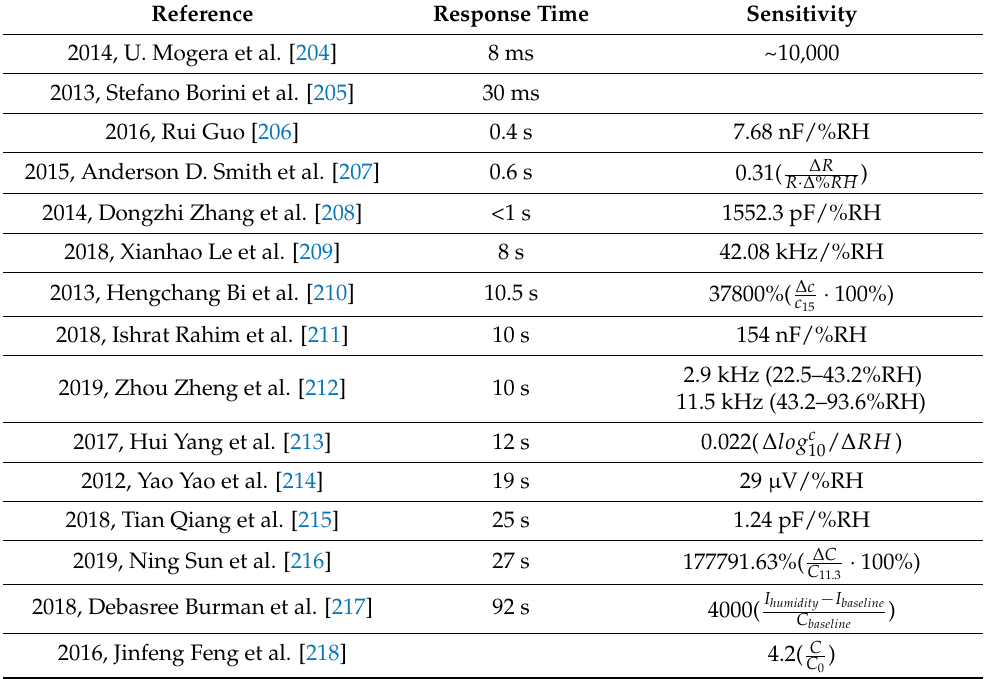
Table 3. Selection of electrical humidity